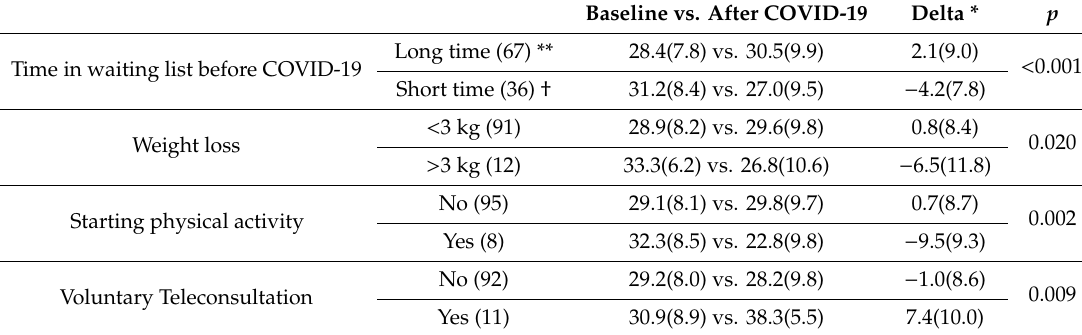
Values are mean (standard deviation). * Delta = Rørvik score evaluated after COVID-19 lockdown minus Rørvik score at baseline. ** Long time = patients waitlisted between May and December 2019; † Short time =